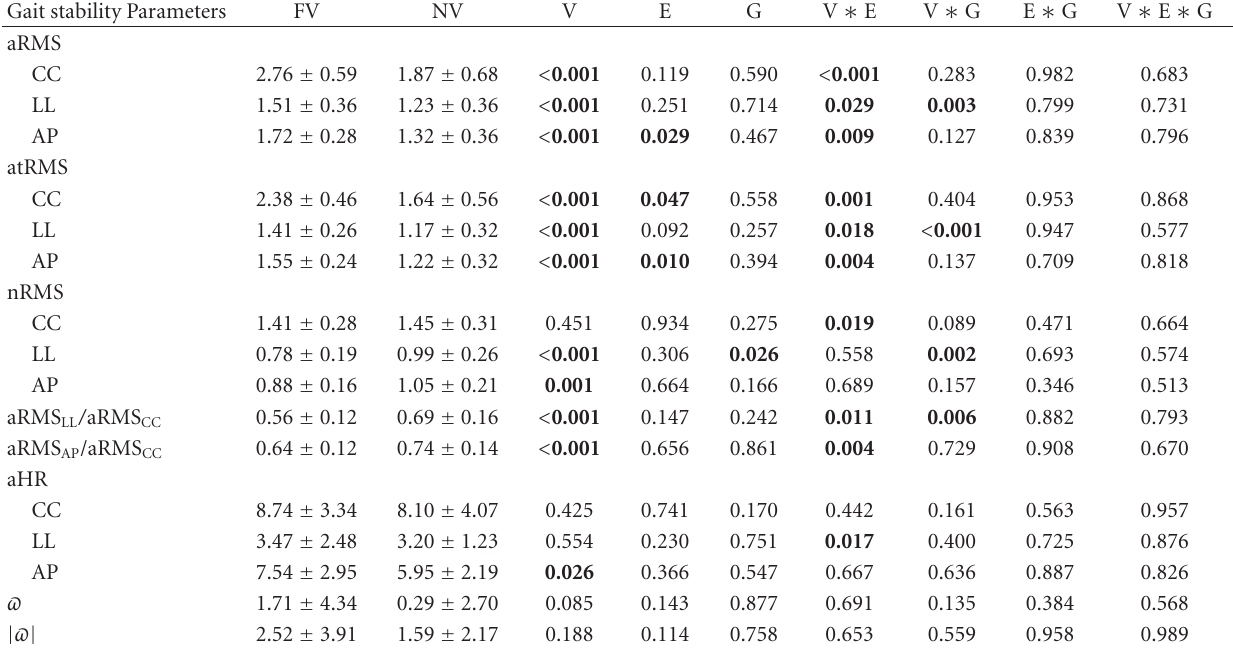
Table 2: E ff ects on gait stability parameters. Mean ± standard deviation of gait stability parameters in full- versus no-vision condition, and the P -values of the e ff ects of vision (V), environment (E), gender (G), and all their possible interactions on upper body accelerations evaluated on three central strides (aRMS), over the entire trial (atRMS), acceleration root mean square normalized by walking speed (nRMS) and by cranio-caudal acceleration (aRMS LL / aRMS CC and aRMS AP / aRMS CC ), harmonic ratio (aHR), mean angular velocity ( (cid:2) ), and its module ( | (cid:2) |